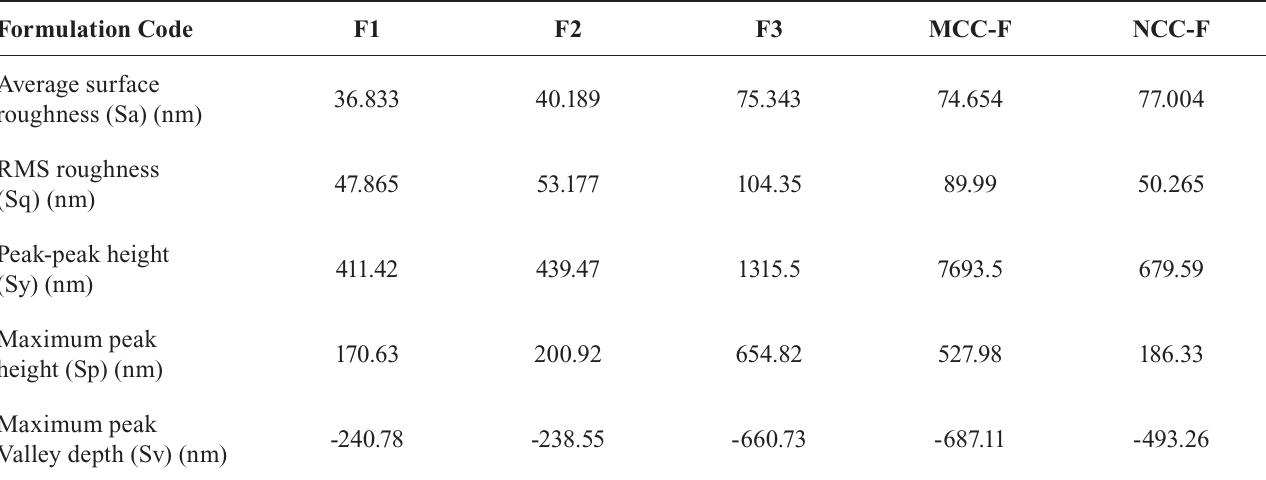
TABLE III - Atomic force microscopy parameters for ODF